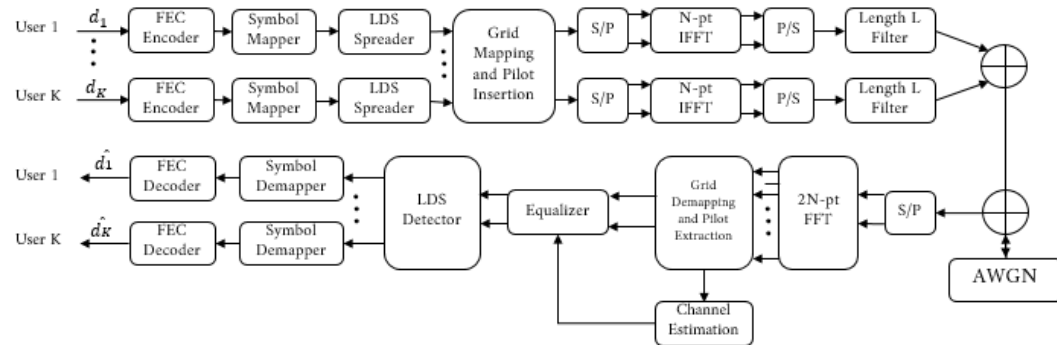
Figure 1. Low Density Signature-Universal Filtered Multi-Carrier (LDS-UFMC) block